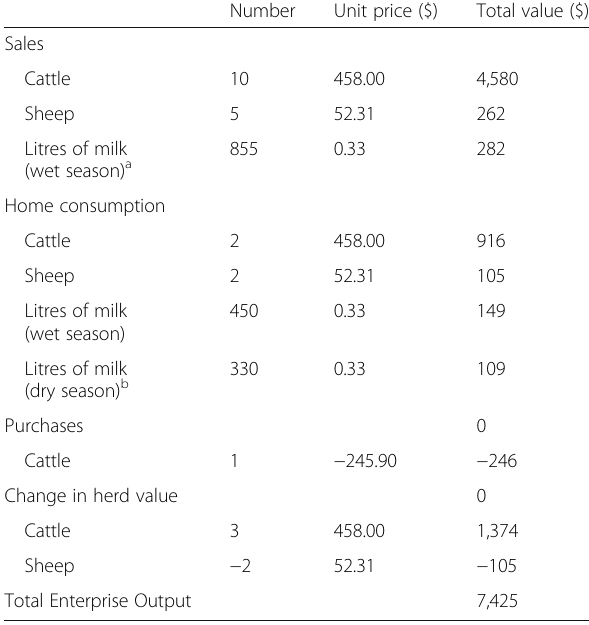
Table 3 Livestock enterprise output using mean household